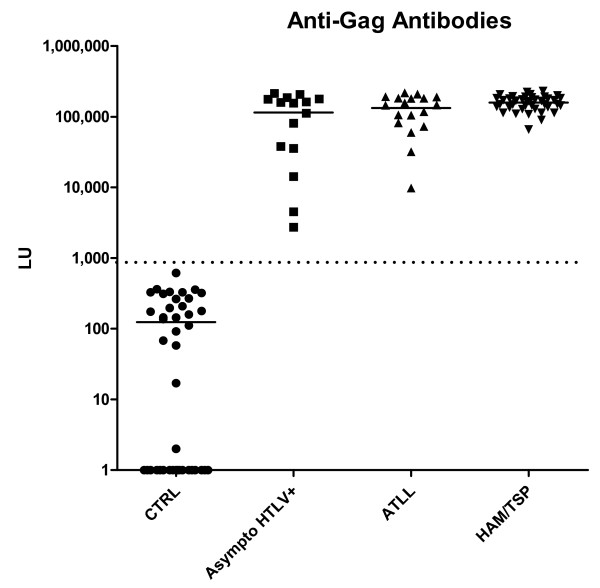
LIPS detection of anti-HTLV-I Gag antibodies. Each symbol represents individual samples from normal control, asymptomatic HTLV-infected, ATLL, and HAM/TSP patients. Antibody titers in LU are plotted on the Y-axis using a log10 scale. The dashed line represents the cut-off level for determining sensitivity and specificity for the particular antigen and is derived from the mean plus 5 SD of the antibody titer of the 42 normal volunteer samples. P values were calculated using the Mann Whitney U test. The solid line indicates the mean antibody titer per group.